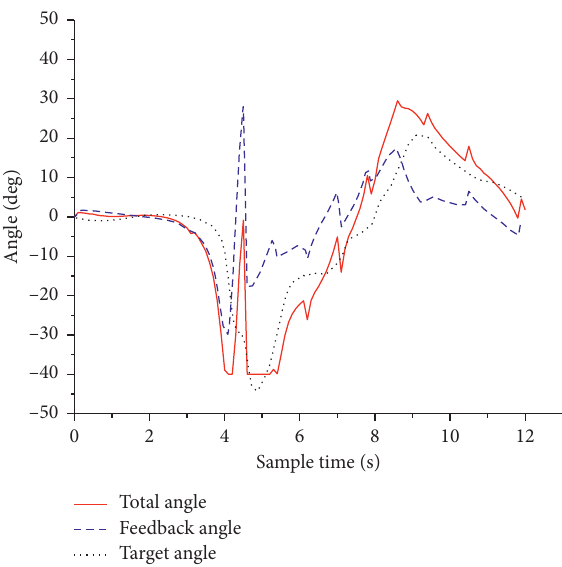
Figure 28: Steering angle analysis diagram.